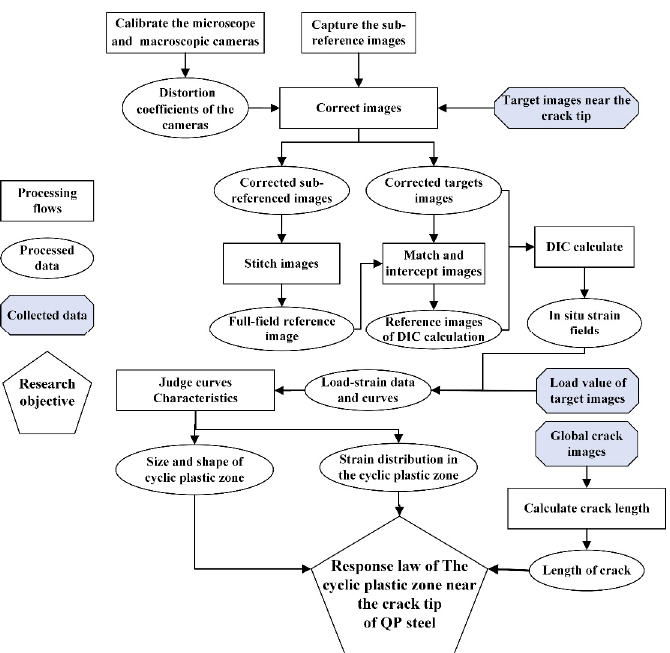
Figure 1. A flow chart of the in situ CPZ and internal response measurement method.